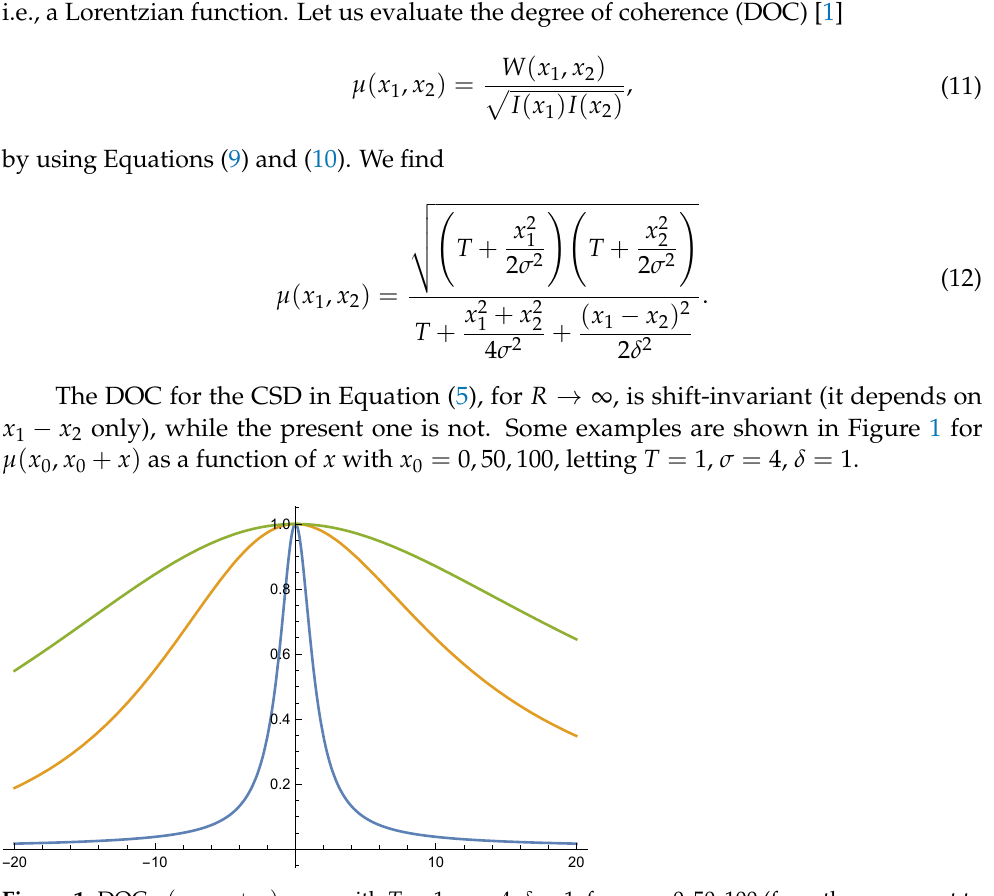
Figure 1. DOC µ ( x 0 , x 0 + x ) vs. x with T = 1, σ = 4, δ = 1, for x 0 = 0,50,100 (from the narrowest to the widest curve).